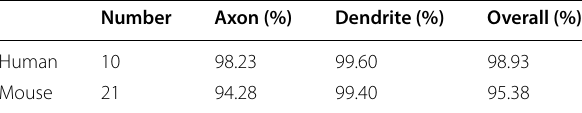
Table 3 Comparison results